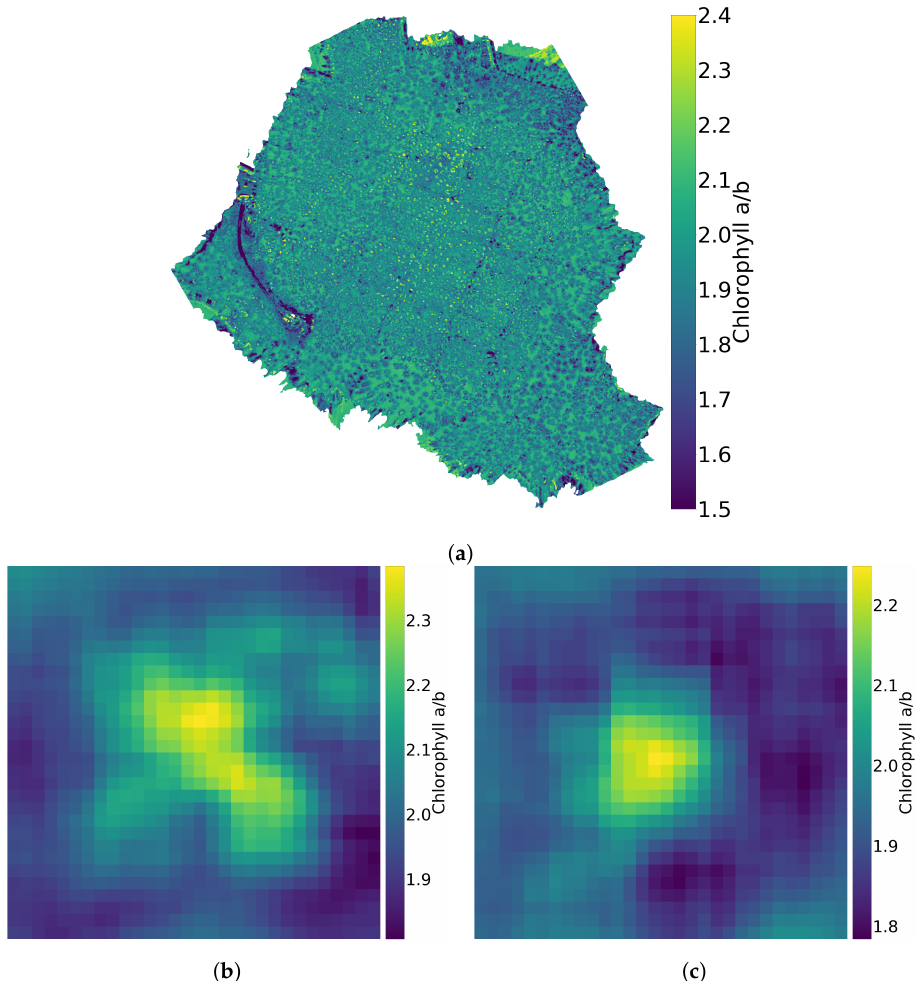
Figure 11. Chlorophyll a values divided by chlorophyll b values for the whole forest ( a ), for a birch ( b ) and for a spruce ( c